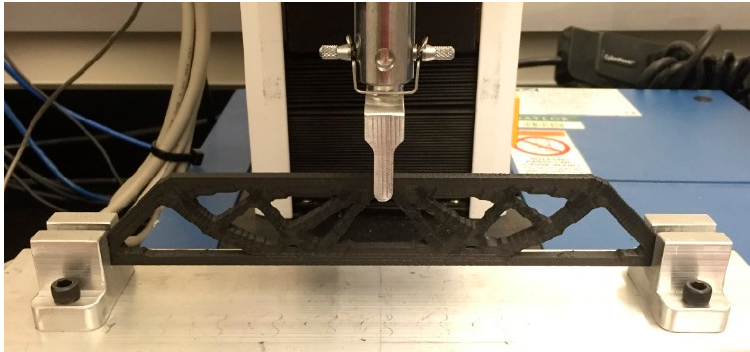
Figure 8. Mechanical test set up for CFAO optimized MBB beam.